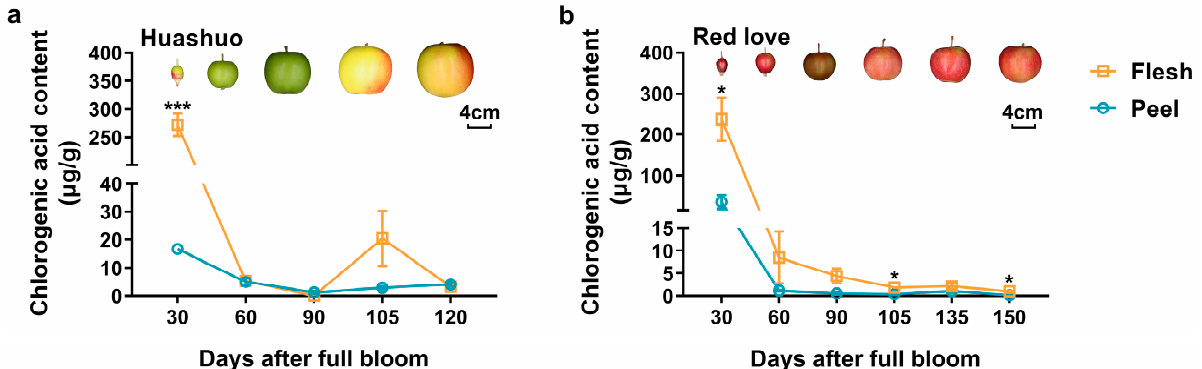
Figure 1. Changes of the CGA content during apple fruit development in the cultivars ‘Huashuo’ ( a ) and ‘Red Love’ ( b ). Apple fruit appearance for the cultivars ‘Huashuo’ and ‘Red Love’ at different stages are shown at the top of the figure (Scale bars = 4 cm). Error bars represent standard errors from three biological replicates. (* p < 0.05, *** p < 0.001).